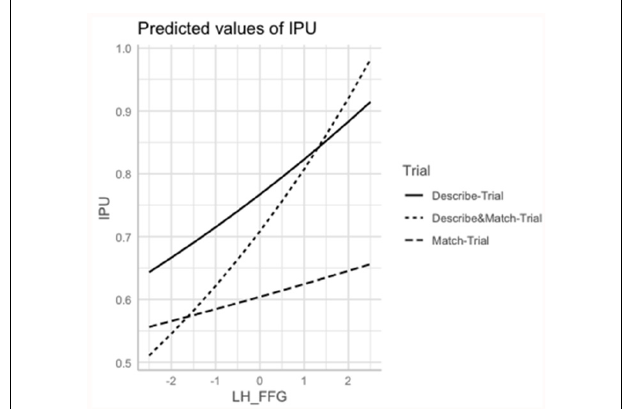
FIGURE 4 | Marginal estimates of Interpausal Unit (IPU) duration (log-transformed) as a function of the Left Fusiform Gyrus (L FFG) in